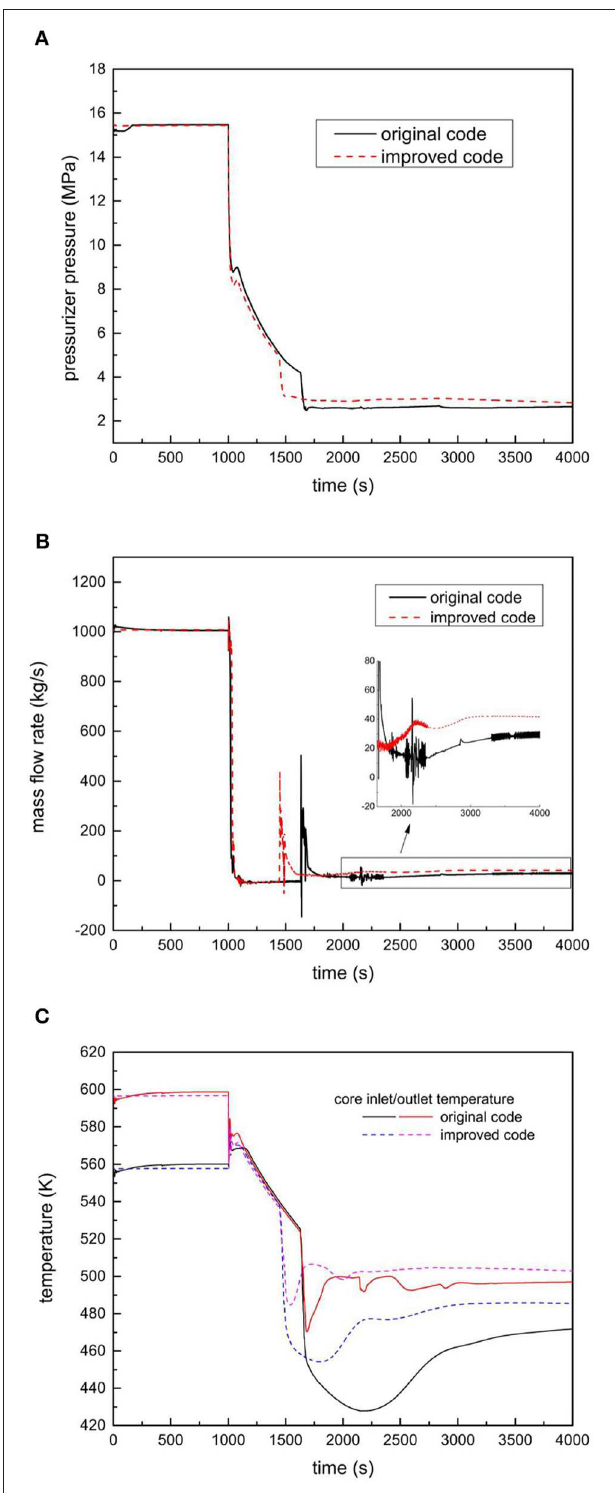
FIGURE 4 | Comparisons between the original and improved RELAP5/MOD3.1 codes. (A) Pressure in pressurizer. (B) Mass flow rate in the core. (C) Coolant temperature at core inlet and